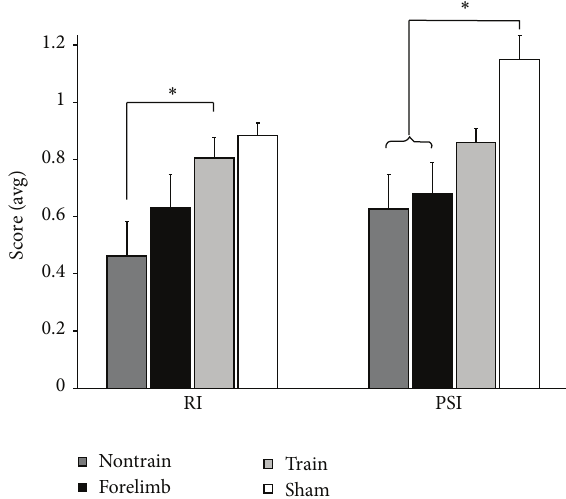
Figure 4: The regularity index revealed a significant difference between the trained and nontrained groups ( ∗ ) (Mann-Whitney 𝑈 test). The plantar stepping index revealed a significant difference between the sham and both the nontrained and forelimb groups ( ∗ ) (ANOVA with Bonferroni post hoc 𝑡 -tests). Parameters of gait were not significant: stride length, stride time, base of support, and toe velocity. Nontrain 𝑛 = 5 ; train 𝑛 = 13 ; forelimb 𝑛 = 6 ; sham 𝑛 = 4 .